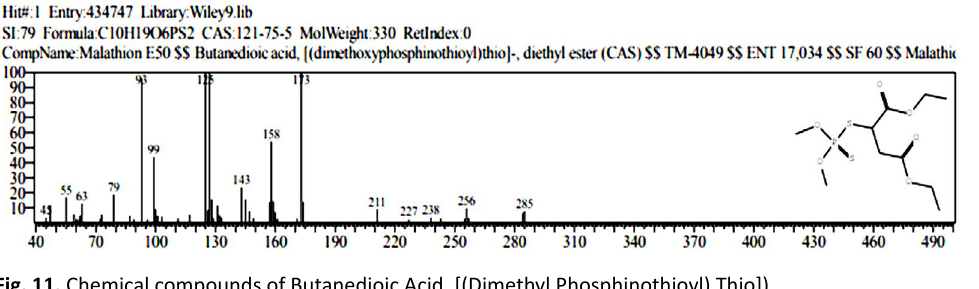
Fig. 11. Chemical compounds of Butanedioic Acid, [(Dimethyl Phosphinothioyl) Thio])